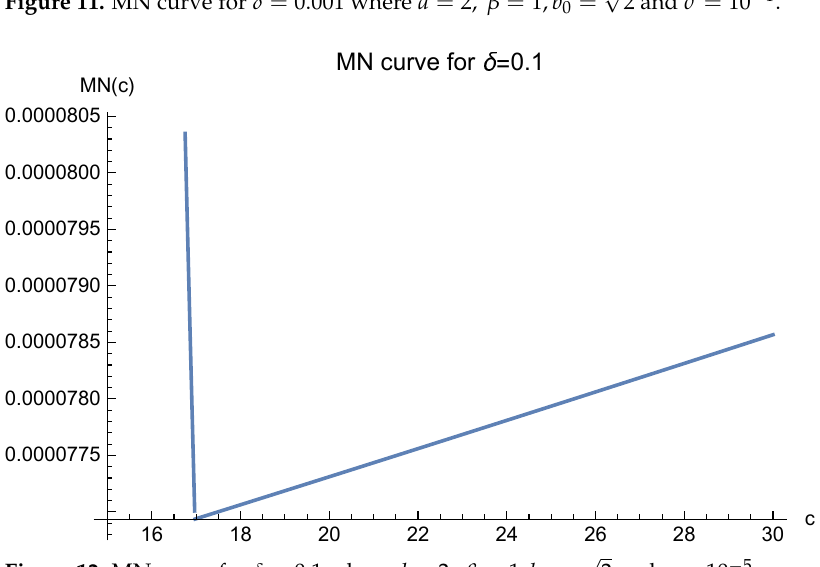
Figure 12. MN curve for δ = 0.1 where d = 2, β = 1, b 0 =